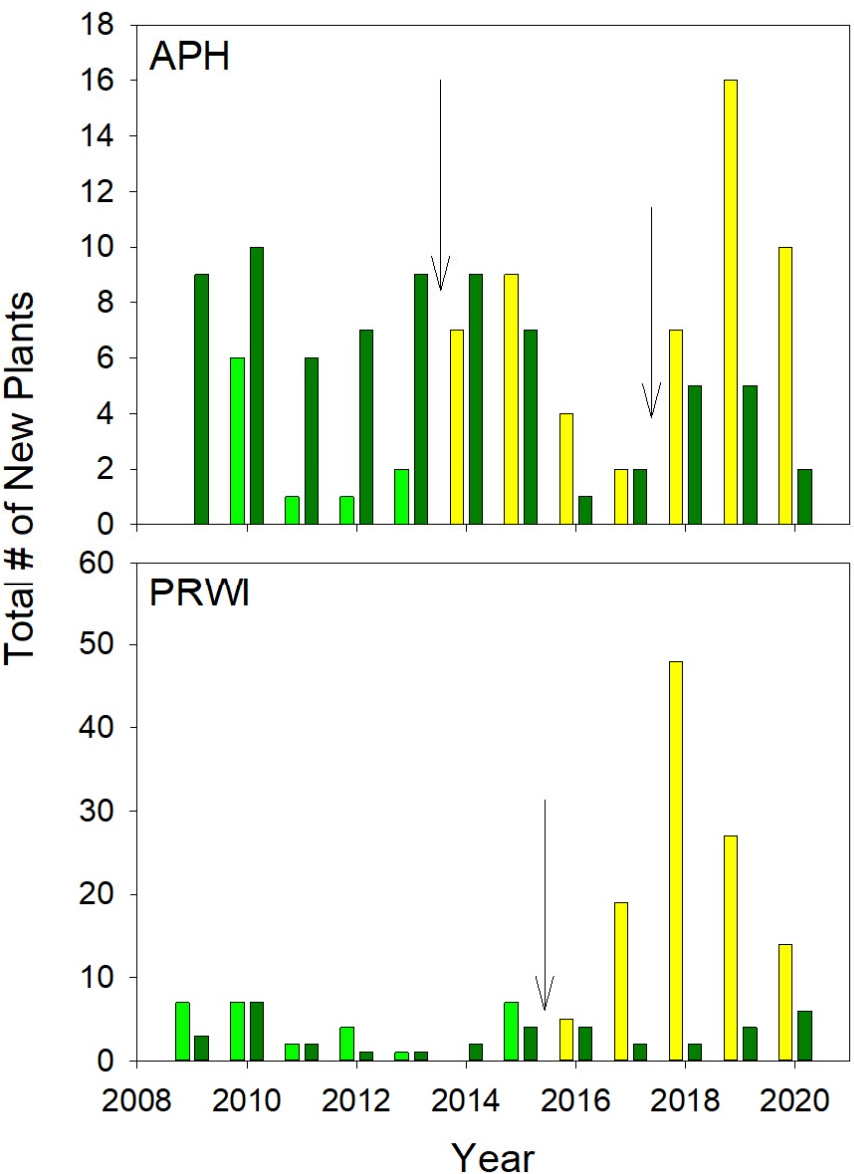
Figure 4. Number of new plants at APH and PRWI. Color codes and arrows are as shown in Figure 3 legend.